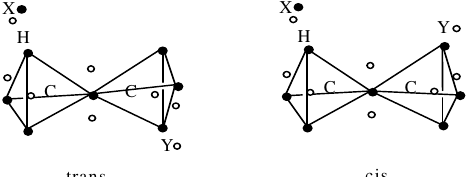
Figure 7. Cis and trans transition state electronic structures in Elimination.